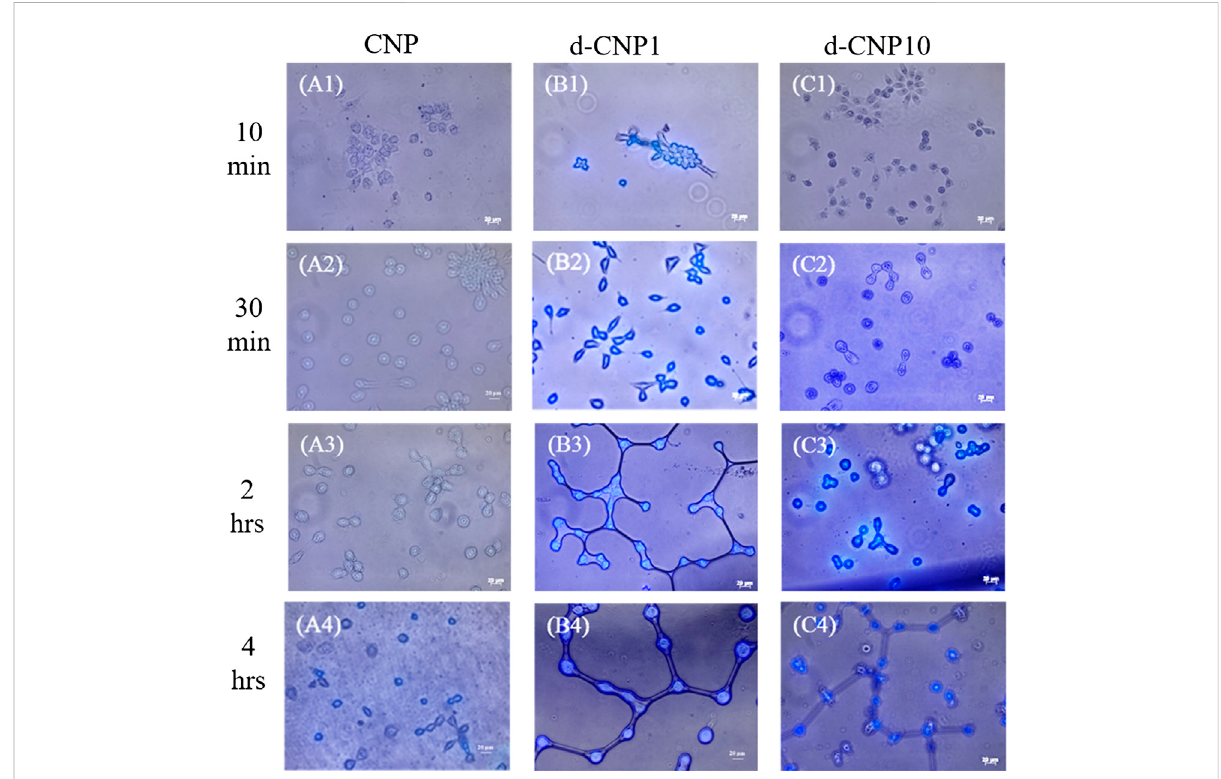
FIGURE 5 Photos of CNP-stained cells after different incubation periods at 4 ° C. (A1)-(A4) for CNP incubated with cells for 10 min, 30 min, 2 h and 4 h, respectively; (B1)-(B4) for d-CNP1 with those corresponding incubation periods; and (C1)-(C4) for d-CNP10 samples with corresponding periods. Scale bar: 20 μ